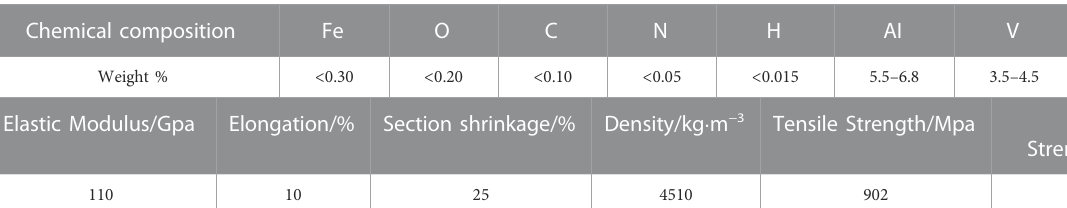
TABLE 1 Chemical composition and room temperature mechanical properties of TC4 titanium alloy. Chemical